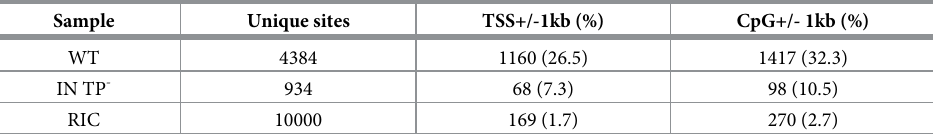
Table 3. Integration site mapping of single round infected WT and IN TP - MLV in K562 cells.